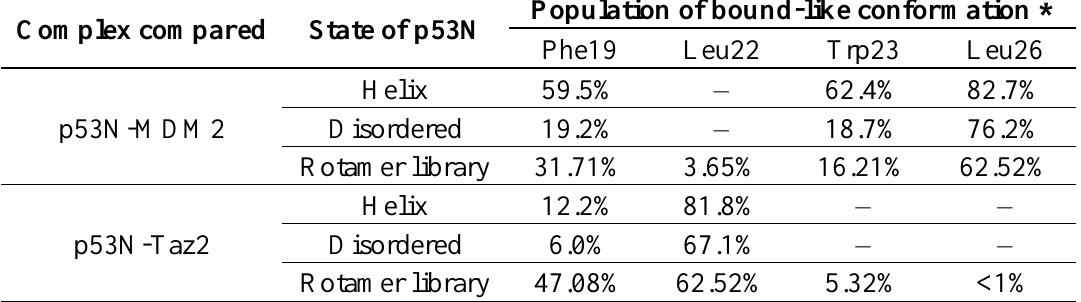
Table 1. Population of bound-like conformations of anchor residues of the unbound p53N in different